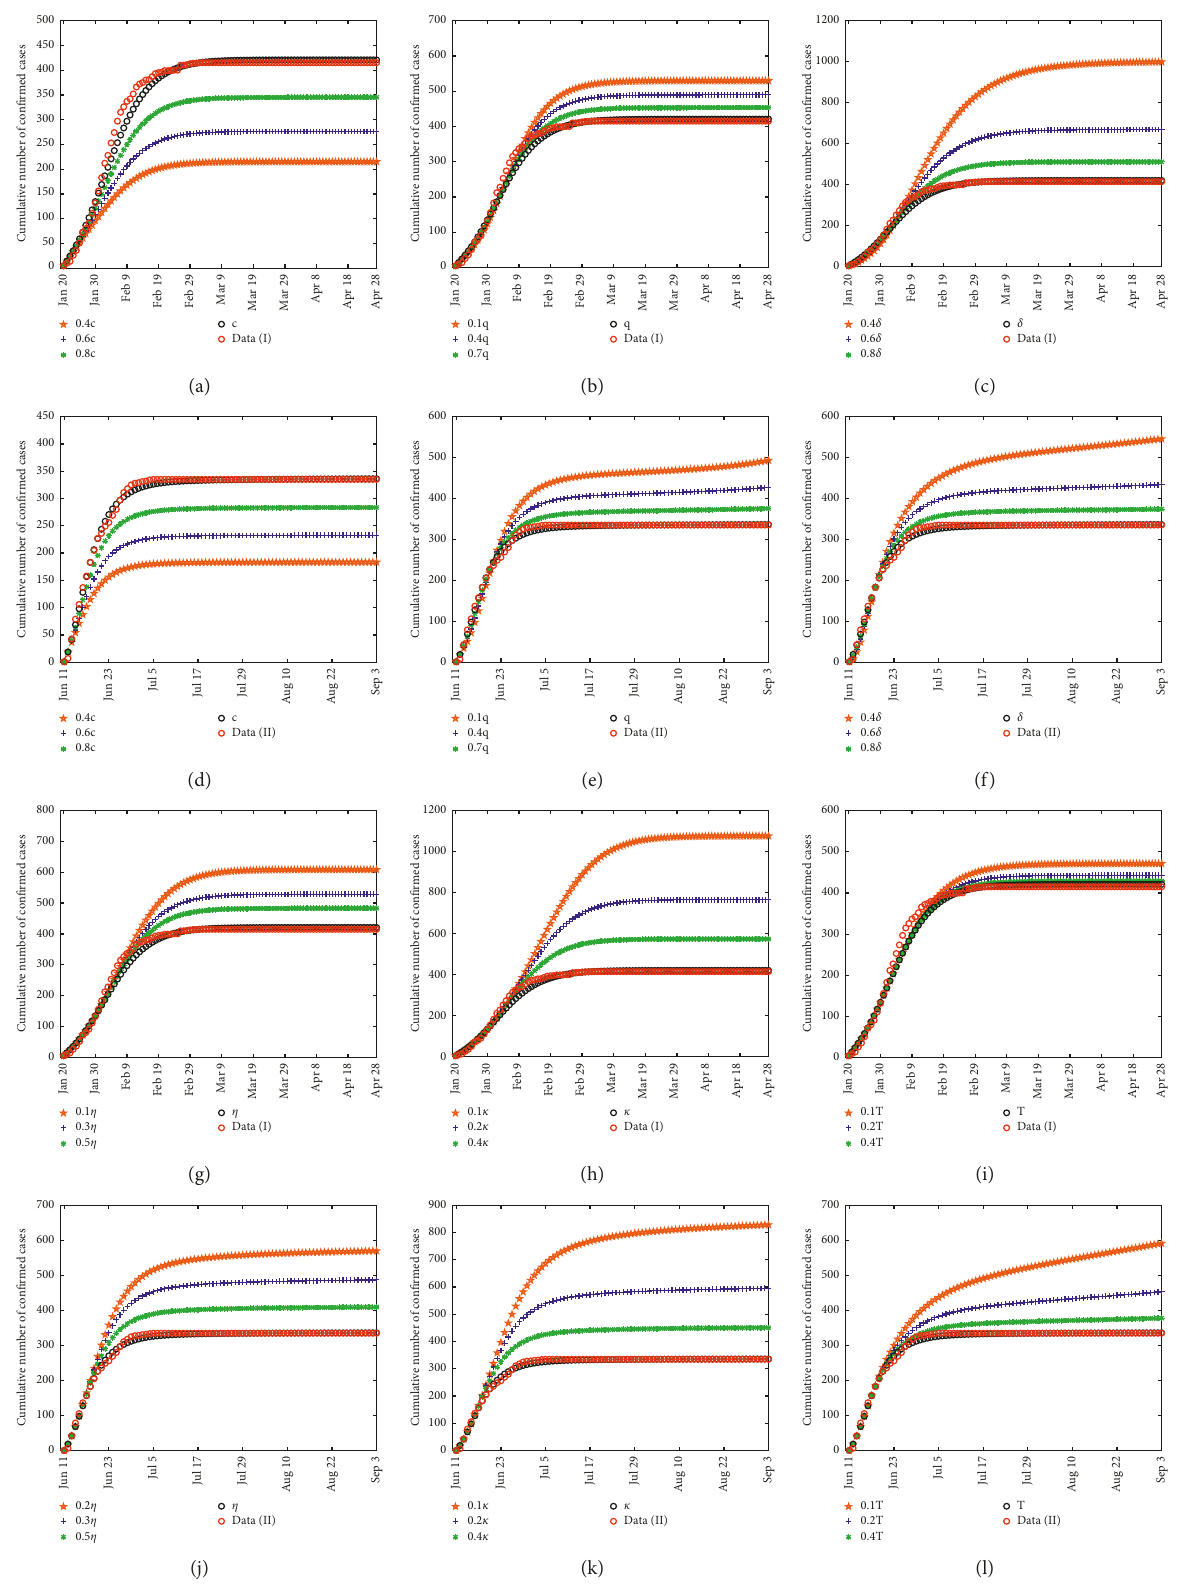
Figure 8: Variation of the cumulative number of confirmed individuals with various values of the contact rate c , quarantine rate q , progression rate of infectives to hospital δ , media-reporting rate η , social-distancing uptake rate κ , and the average time of social distancing T for both the first outbreak ((a)–(c) and (g)–(i)) and the second outbreak ((d)–(f) and